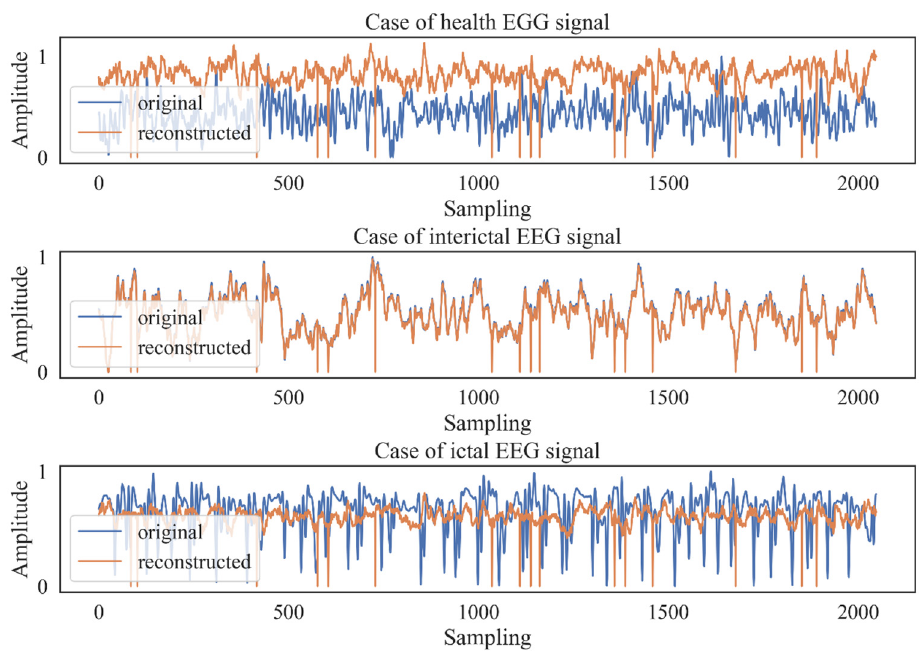
Figure 7. Reconstruction results for the healthy, interictal, and ictal EEG signals.